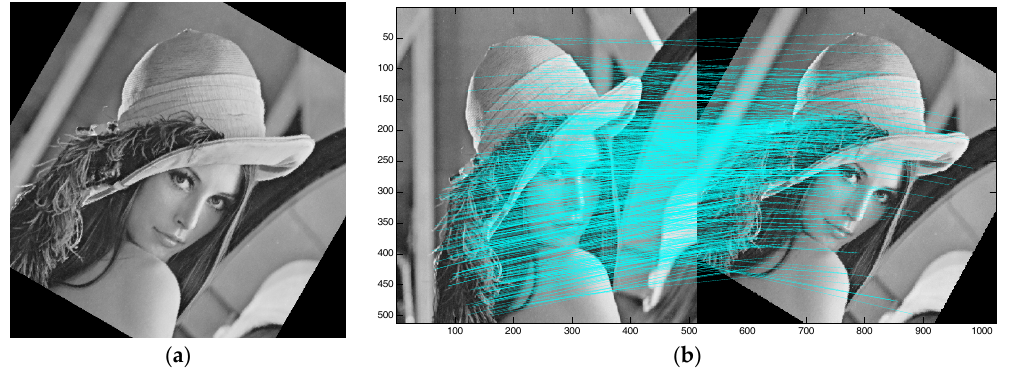
Figure 5. Matching between rotated image and watermarked image: ( a ) rotated image (30°); ( b ) feature matching.